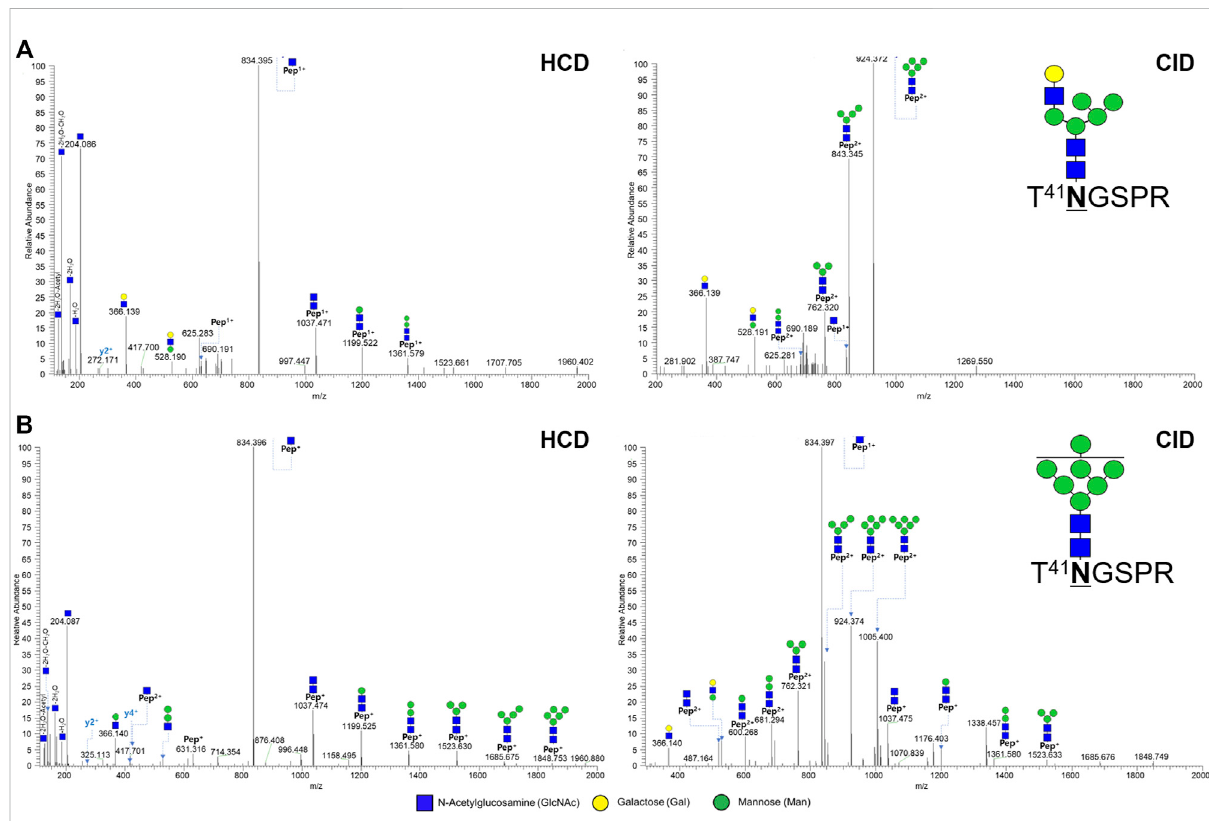
FIGURE 3 Representative tandem spectra of novel N-glycopeptide of the hybrid type and the high-mannose type from In fl iximab. (A) T 41 NGSPR_6_3_0_0_0 (m/z 738.63, 2+) of the hybrid type N-glycopeptide and (B) T 41 NGSPR_7_2_0_0_0 (m/z 1,086.93, 2+) of the high-mannose type